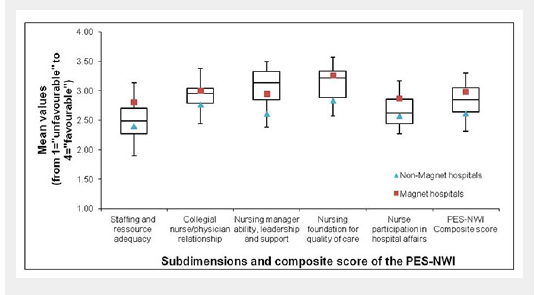
The quality of the nurse work environment in our sample (box plots), compared to work environments in Magnet and Non-Magnet